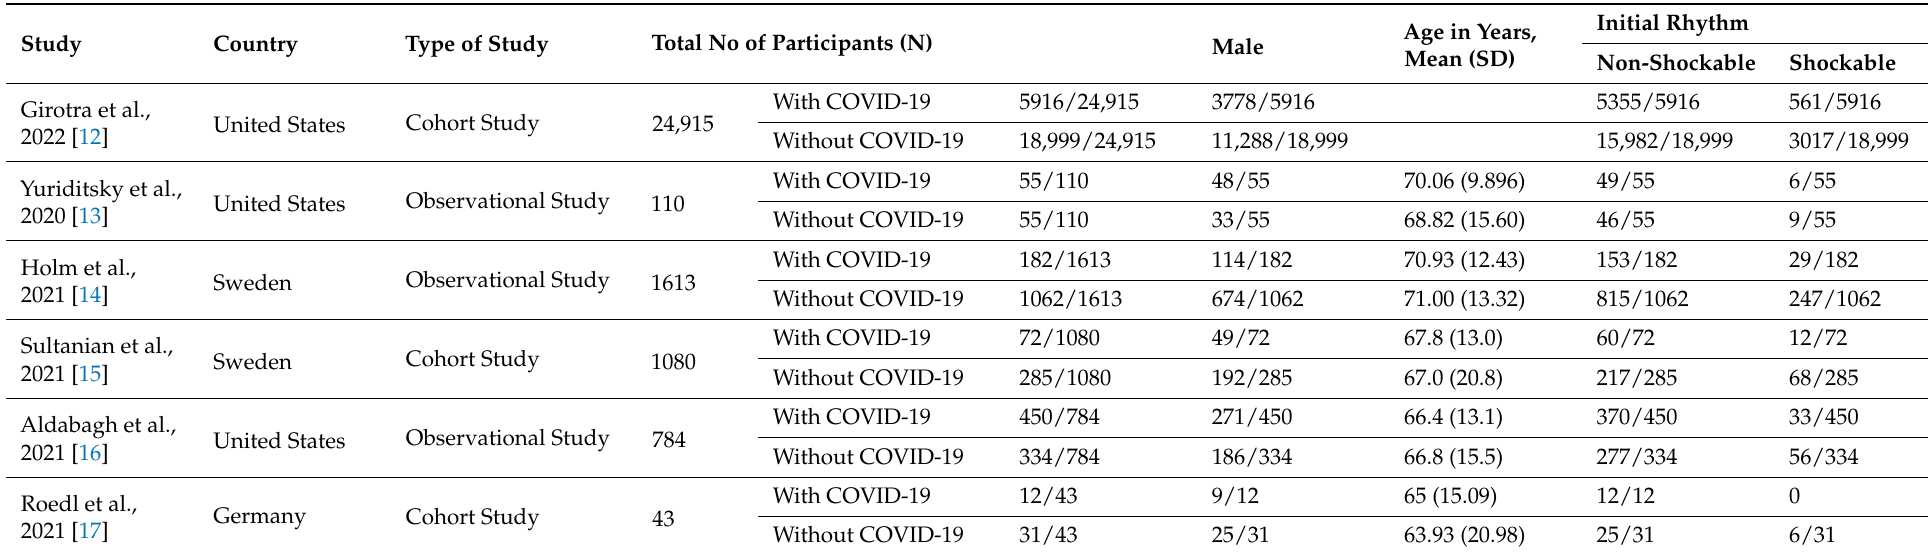
Table 2. Baseline characteristics of included